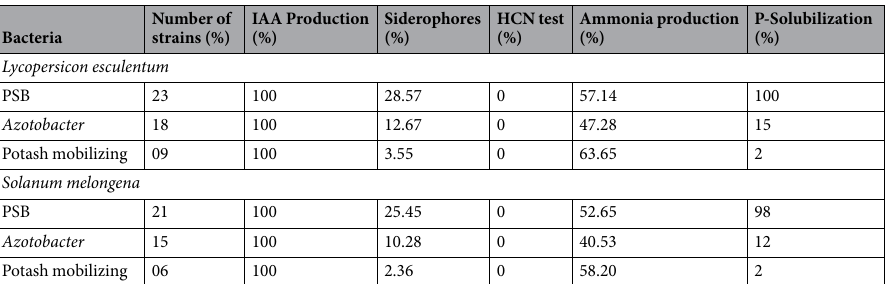
found in case of treatment, T6. The number of fruits per pot was maximum for T6 (23) while, minimum for T1 (5). The weight of the fruits showed an increase with an increase in the rates of application of VCF proving FA to have good fertilizing activity. Significant ( p < 0 . 05 ) variances were found in the yield of fruit per plant along the treat- ments. The yield of fruits per L. esculentum plant was high for treatments T5 (922.48 g/plant) and T6 (952.29 g/plant). The number of S . melongena fruits per pot was found to be maximum in T6 and minimum in T1 (Table 5). Maximum yield in fruits per plant was observed for T6 (1293.13 g/plant) followed by T5 (1249 g/plant) and T4 (1293.13 g/plant). Regression equations depicting the relationship between VCF concentration and fruit yield were derived for both the crops and are depicted in Fig. 6(a,b).